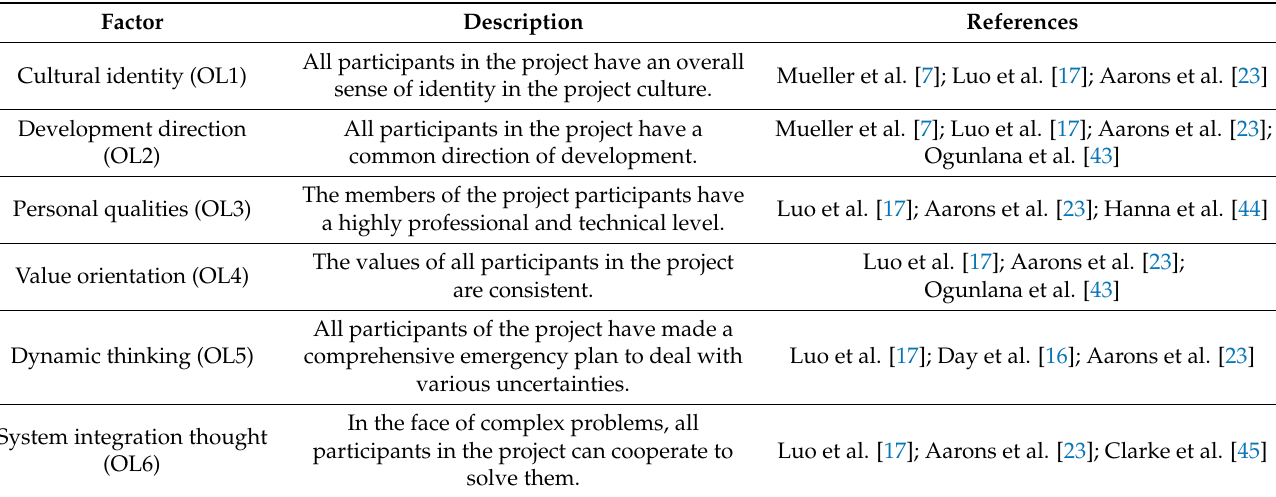
Table 1. Organizational leadership measures of complex construction projects from the literature